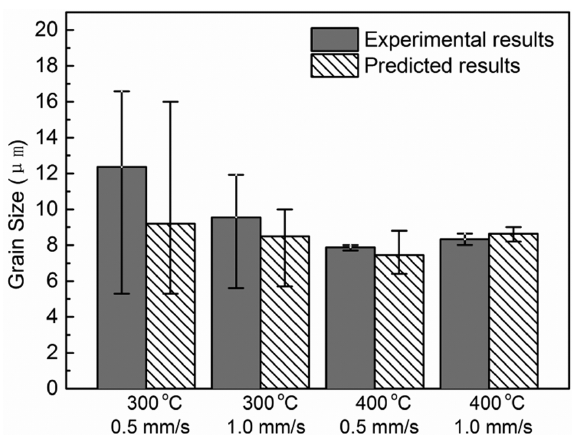
Figure 13: Comparisons between the experimental and simulated results (average grain